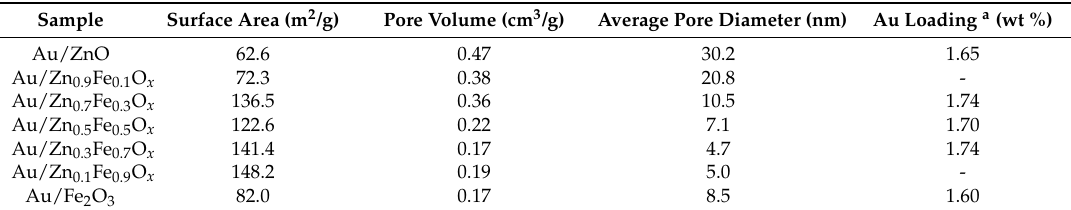
Table 2. BET surface area, pore volume, average pore diameter, and actual gold loading of the supported gold nanocatalysts.